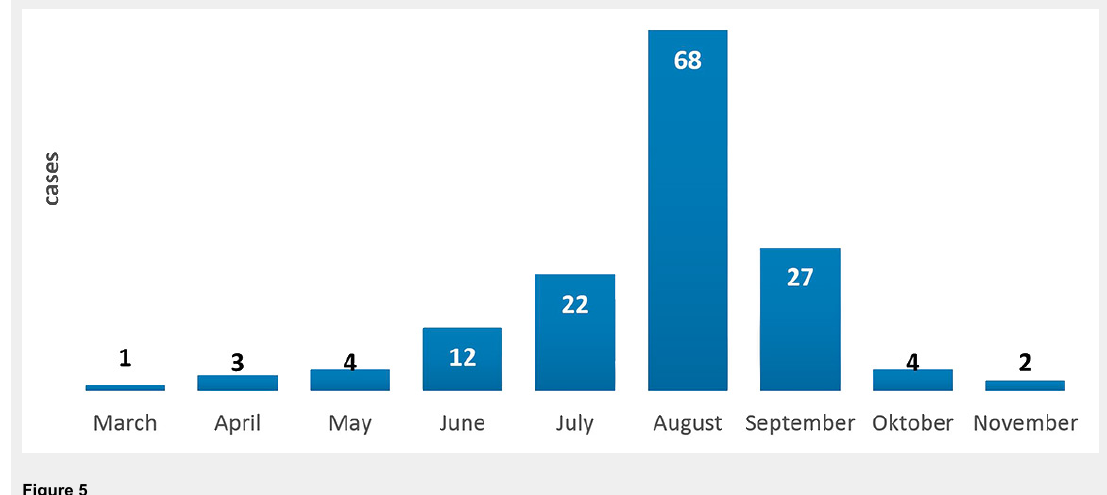
Figure 5 Distribution of cases by month. Case numbers are depicted by month.